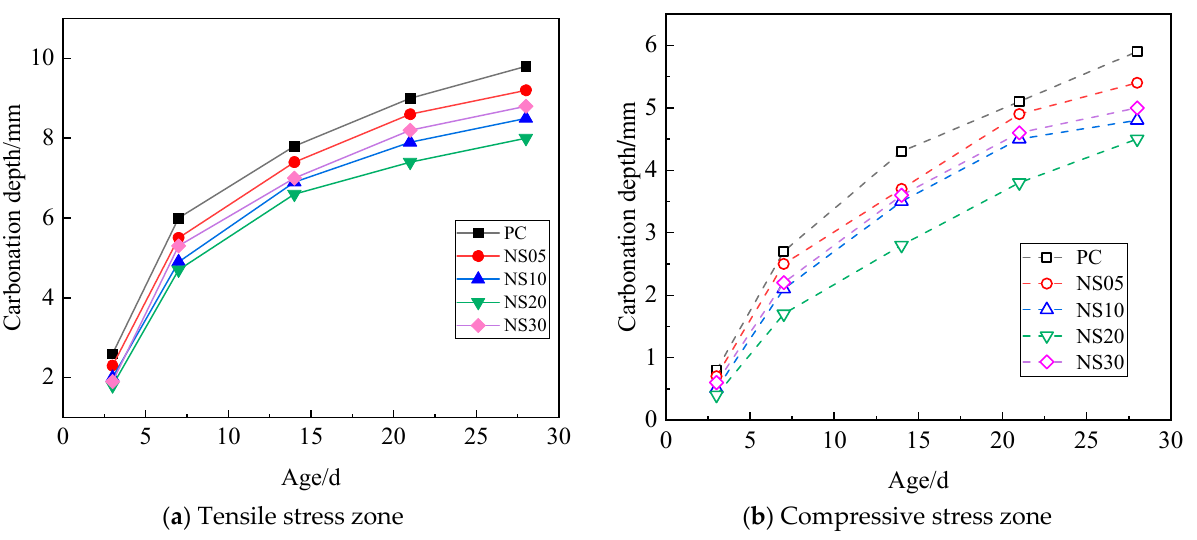
Figure 5. The connection between age change and the carbonation depth of concrete with nano-SiO 2 (stress level is 0.6).